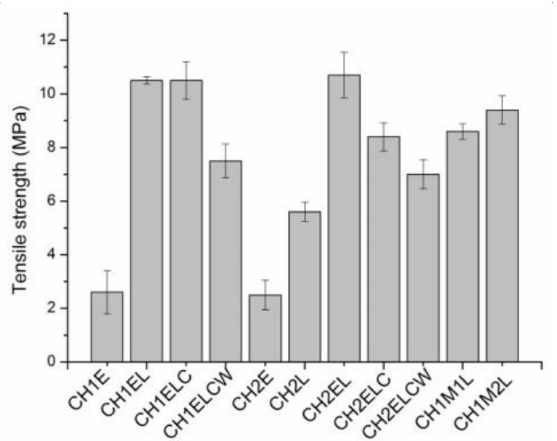
Figure 5. Tensile strength for chitosan/starch-based samples.